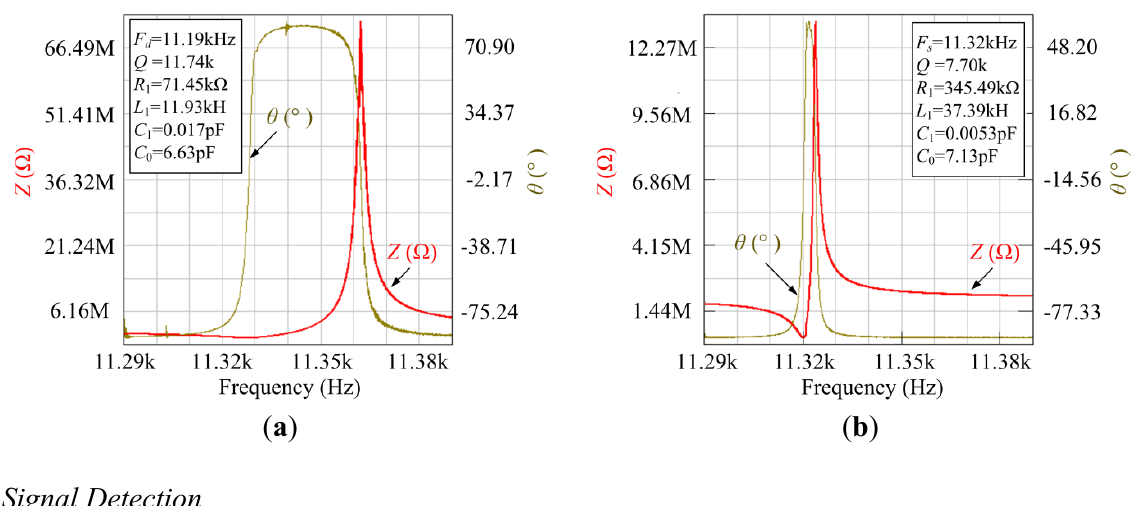
Figure 11. Impendence testing. ( a ) Impedance characteristic of drive mode and ( b ) Impedance characteristic of sense mode.